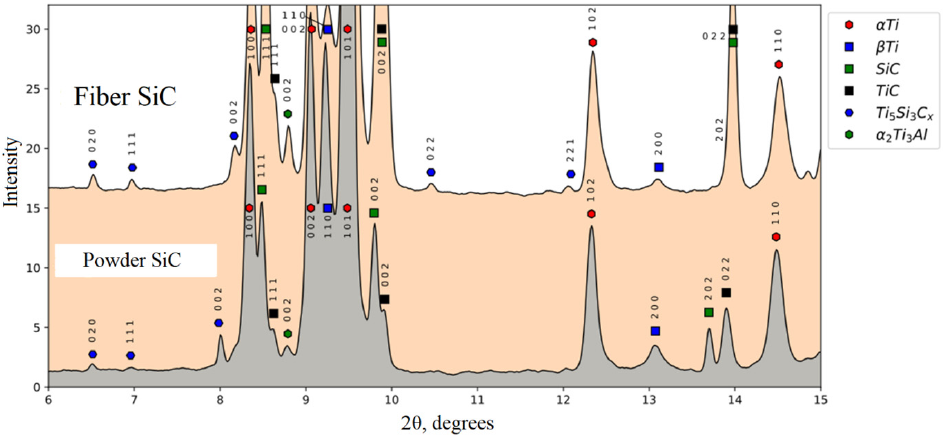
Figure 5. Diffraction patterns of the composite material Ti64-SiC powder and Ti64-crushed fiber SiC). Using ceramic fiber induces more active filling the metal matrix with secondary- formed reinforcing compounds, which causes an increase in mechanical